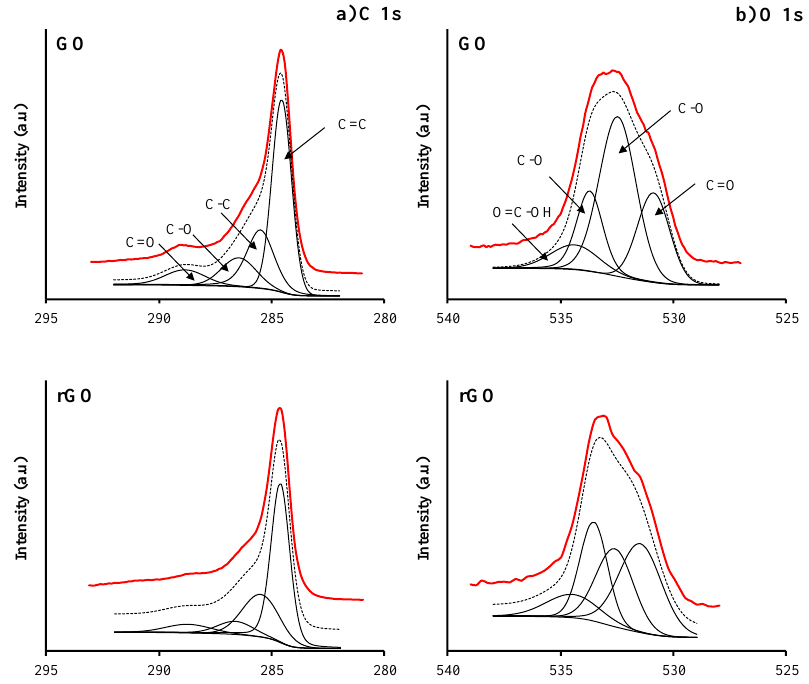
Figure 8. XPS profiles of GO and rGO: ( a ) C 1s spectra and ( b ) O 1s spectra. Continuous red line: experimental profile; discontinuous black line: fitted profile. Table 6. C / O ratio, species percentages, bond energies (in brackets, eV), and oxygen content obtained by XPS